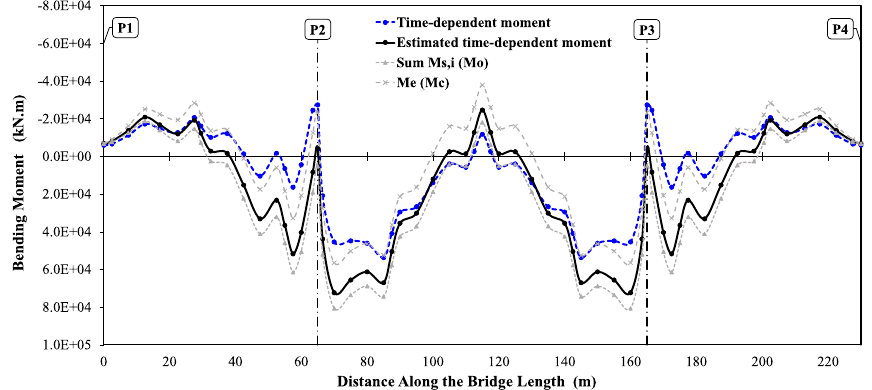
moment from simplified approach–Talkha Bridge